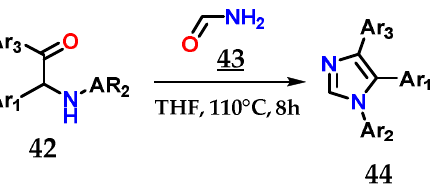
Figure 19. Obtaining 1,4,5-trisubstituted imidazoles 44 from the coupling of α-aminoketones 42 with formamide 43 .